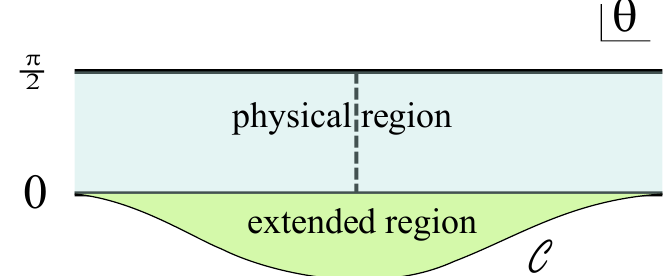
Figure 11 . Extended region of analyticity. We generically extend the region below the real axis (across the physical cut) to a curve C . A well defined dual problem requires a regularization, namely a bound on the analytic function on C . An example of such curve is in figure 3 in which case the curve C is Im θ = b . There we also extended the region to Im θ = b 1 same